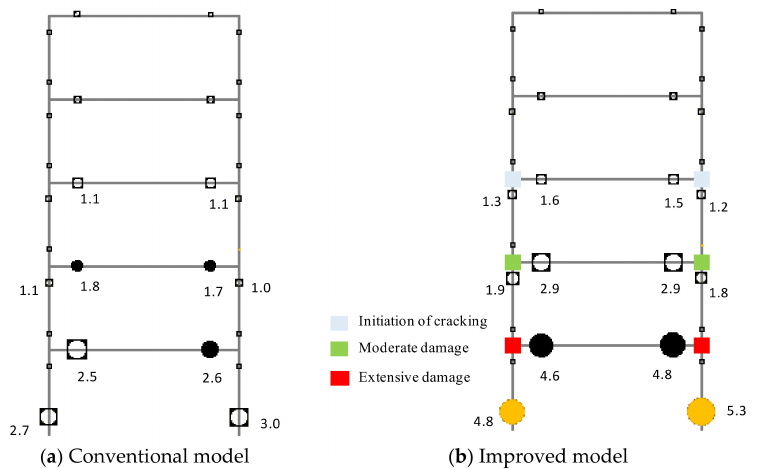
Figure 19. Response comparison for a five-story frame using a conventional model with elastic joint ( a ) and a model with a nonlinear joint model and improved frame element formulation ( b ) The member chord rotation value is given in